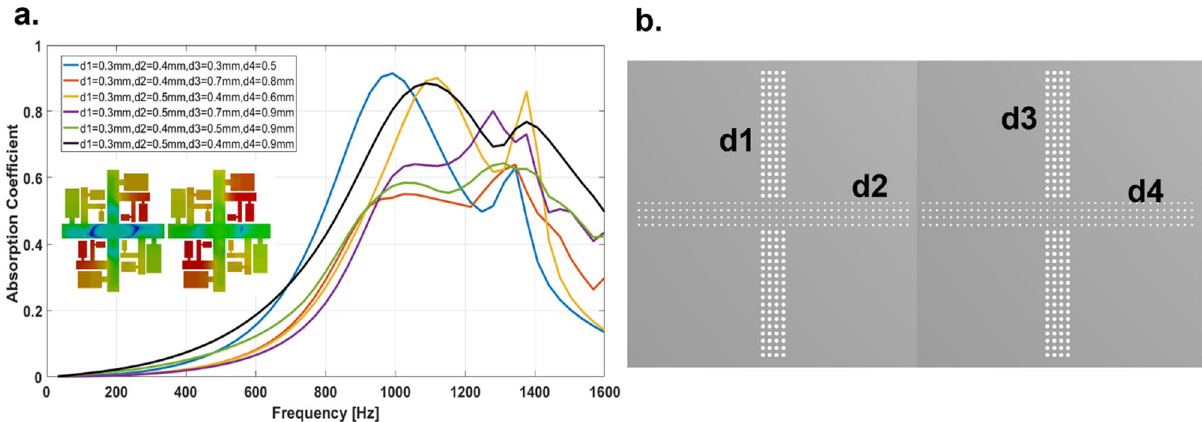
Figure 4. Two-unit cells with different cross perforation. ( a ) Sound absorption coefficient of combined two- unit cells with different cross porosity. ( b ) Top view of the samples of two-unit cells. Courtesy (ANSYS 17.0 45 and MATLAB R2016a 46 ).